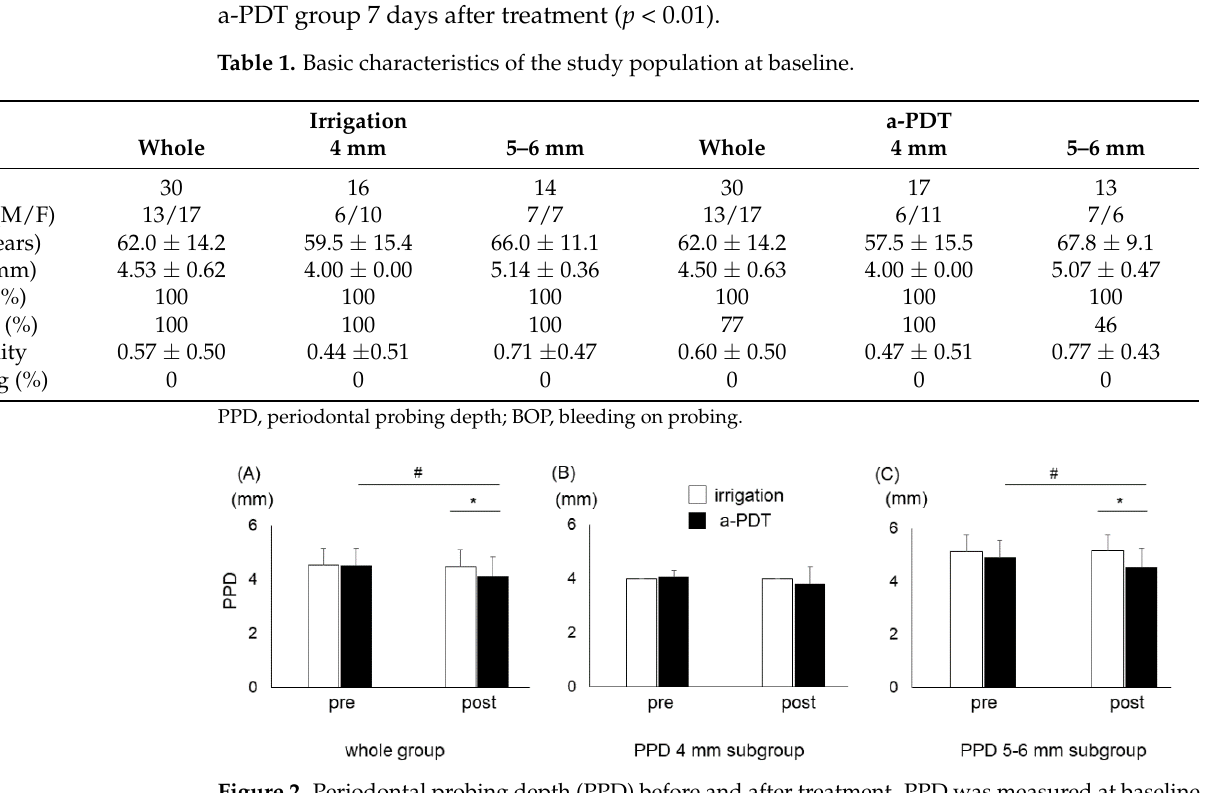
Figure 2. Periodontal probing depth (PPD) before and after treatment. PPD was measured at baseline and 7 days after irrigation or antimicrobial photodynamic therapy (a-PDT). Graphs show mean pre- and posttreatment PPD levels and standard deviations of the whole group ( A ), the 4 mm PPD subgroup ( B ), and the 5–6 mm PPD subgroup ( C ). # p < 0.01 in relation to comparisons between the treatments using paired t -test; * p < 0.01 in relation to comparisons between the groups using t -test.